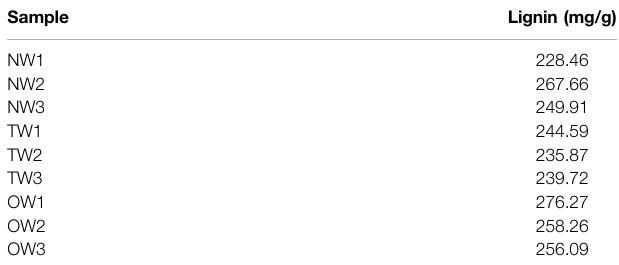
TABLE 3 | Lignin content of normal (NW), tension (TW), and opposite wood (OW). Sample Lignin (mg/g) NW1 228.46